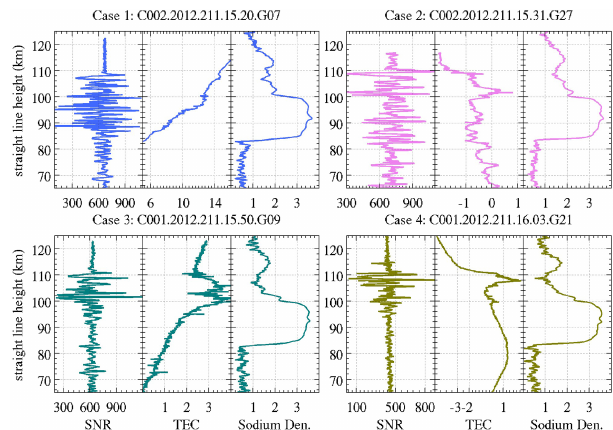
Figure 7. Altitude variations of L1 SNR and relative slant TEC of RO events and Na density of lidar observations corresponding to the four cases shown in Fig. 6. The unit of Na density is cm − 3 and is represented logarithmically in the